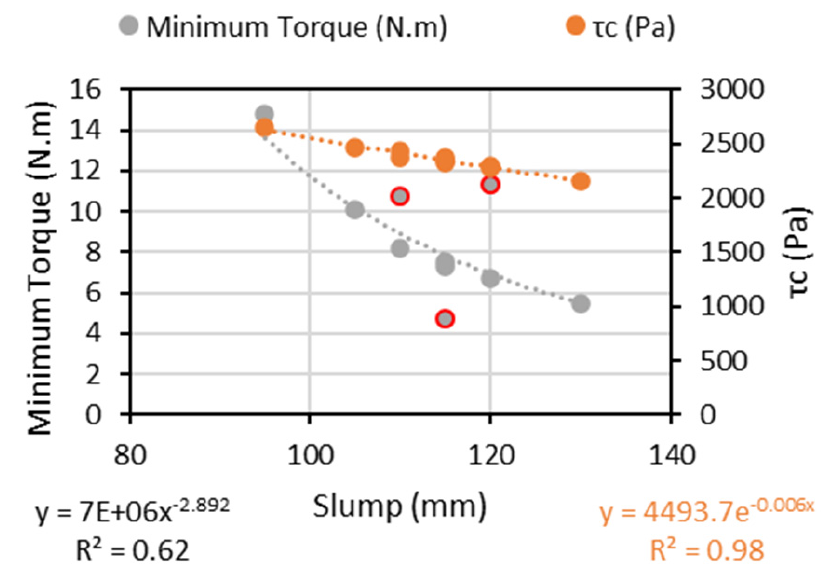
Figure 11. Yield stress experimental versus calculated through Roussel model.